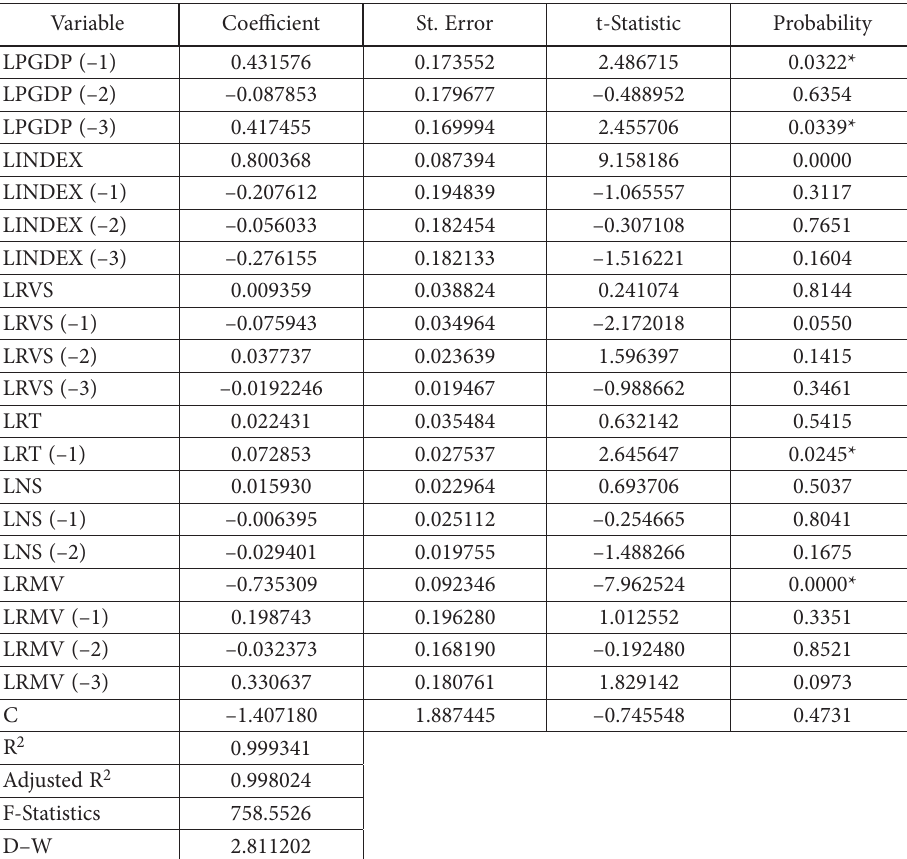
Table 5. The ARDL regression with dependent variable LPGDP